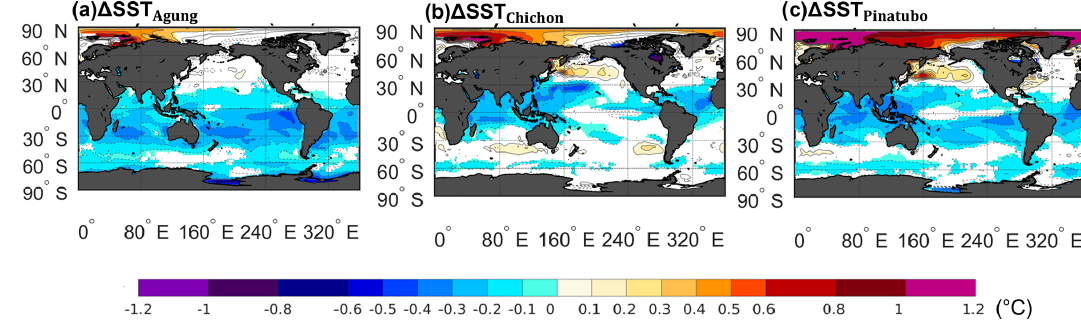
Figure A18. Ensemble mean of changes in sea surface temperature (SST) (shadings) between the volcano case and the climatology for the year following the Agung (a–c) , El Chichón (d–f) and Pinatubo (g–i) eruptions. Contours show the SST anomalies following the colour bar scale (solid lines for positive anomalies and dashed lines for negative anomalies; the 0 line is omitted).